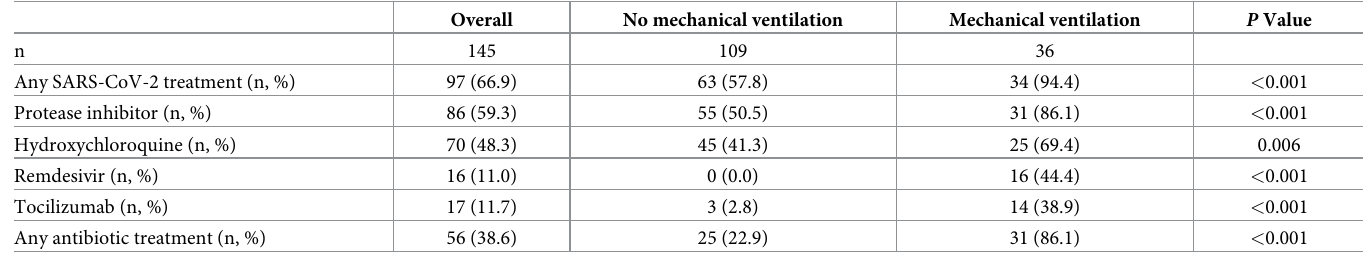
Table 5. Treatments received by patients during the follow-up